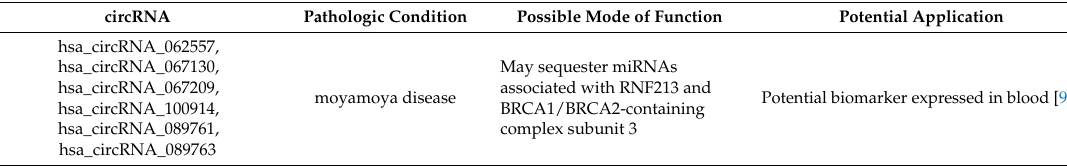
Table 1. Examples of circRNA and their potential role in